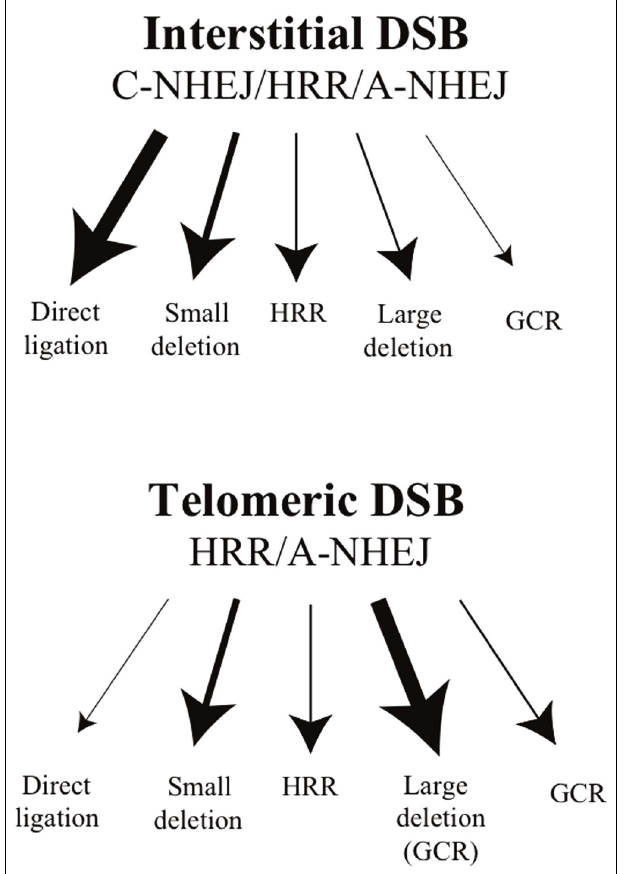
FIGURE 2 |The types of events resulting from interstitial and telomeric I- Sce I-induced DSBs. DSB repair at interstitial sites occurs primarily by C-NHEJ, although some DSBs are also repaired by HRR, involving error-free repair, and A-NHEJ, which is associated with large deletions and GCRs. Direct ligation of the ends of DSBs without the loss of the I- Sce I site by C-NHEJ is the most common event at interstitial DSBs. Small deletions of a few base pairs that eliminate the I- Sce I site are the next most common event, followed by HRR, large deletions, and GCRs.The deficiency in NHEJ near telomeres is proposed to be due to inhibition of C-NHEJ, while the efficiency of HRR is unchanged. As a result, most DSBs near telomeres are repaired by A-NHEJ. Consistent with a predominant role for A-NHEJ in repair of telomeric DSBs, large deletions are the most common event at I- Sce I-induced DSBs near telomeres. Most of these large deletions would also result in GCRs, because they cause the loss of the telomere. GCRs that occur without large deletions are also greatly increased at DSBs near telomeres, while small deletions of a few base pairs occur at the same frequency as at interstitial